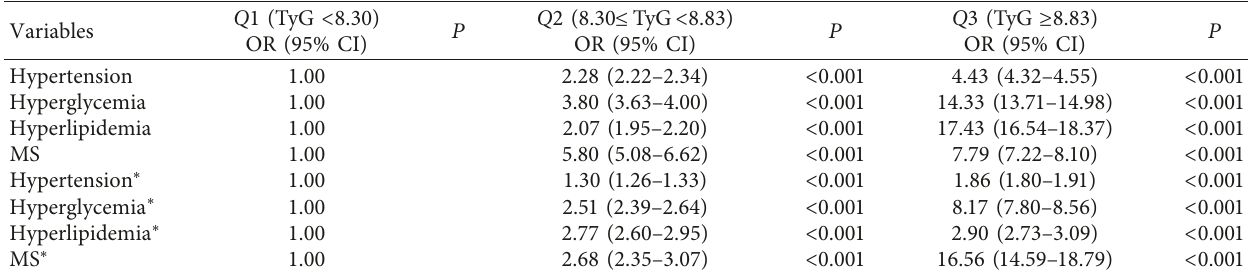
Table 2: Multiclass logistic regression among the TyG-index